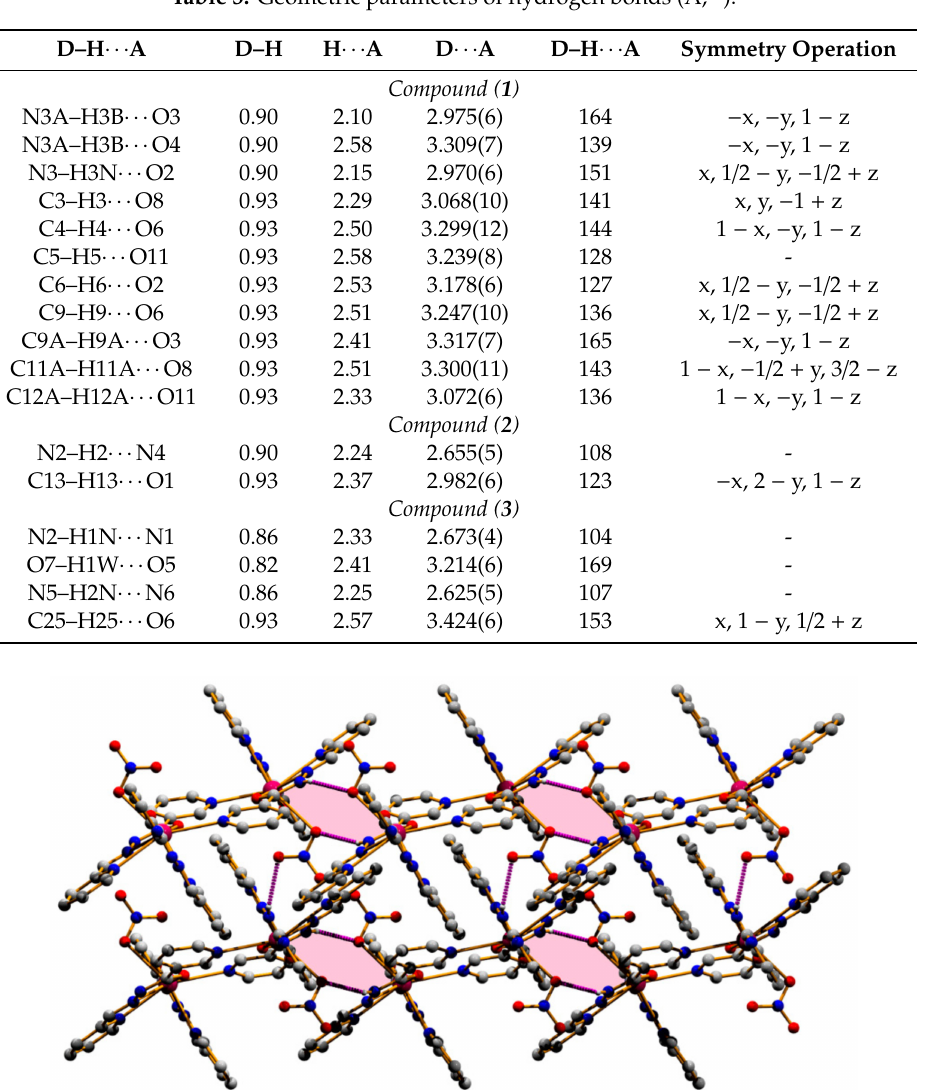
Table 3. Geometric parameters of hydrogen bonds (Å, ◦ ).